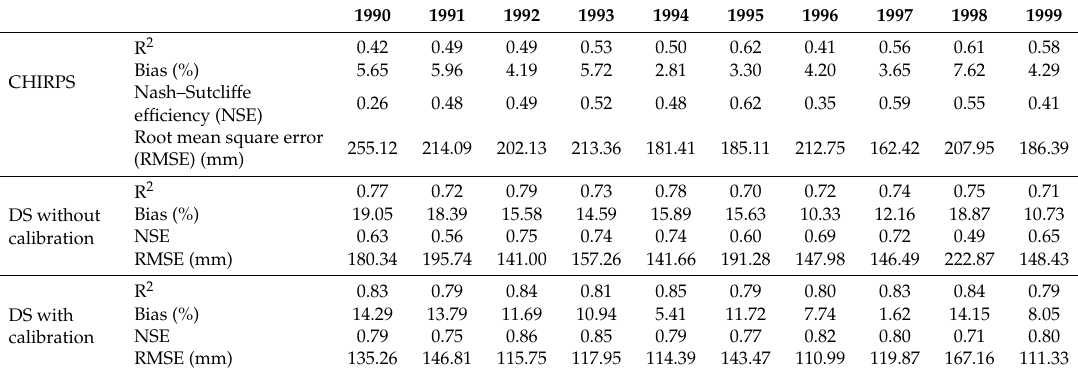
Table 3. Statistical results of the CHIRPS data, the DS without and with gauge calibration, against ground observations in the years from 1990 to